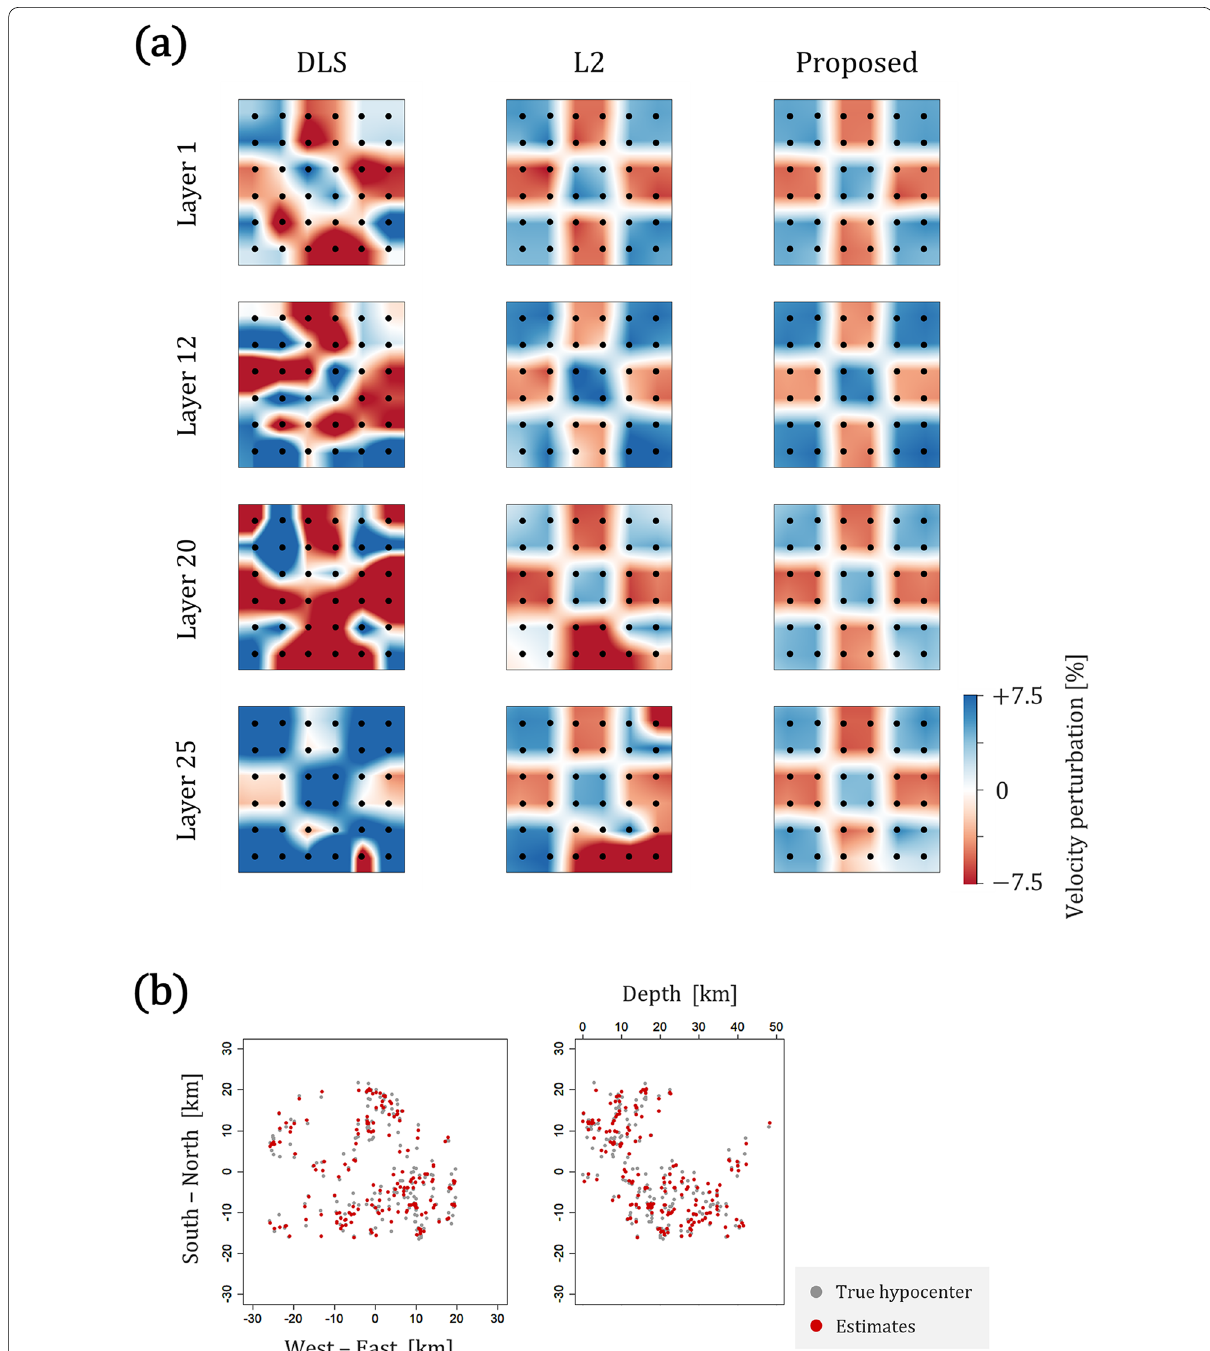
Fig. 5 a Anomalies of the estimated velocities from the baseline velocities in several layers for the estimation methods. Dots represent grid points. b Locations of relocated hypocenters in map-view (left) and cross-sectional view along a north–south profile (right). Grey and red circles represent the true (initial) and relocated hypocenters, respectively. East, north, and down directions are positive. The origin of the coordinates is 35.25 ◦ N, 138.25 ◦ E, and 0 km